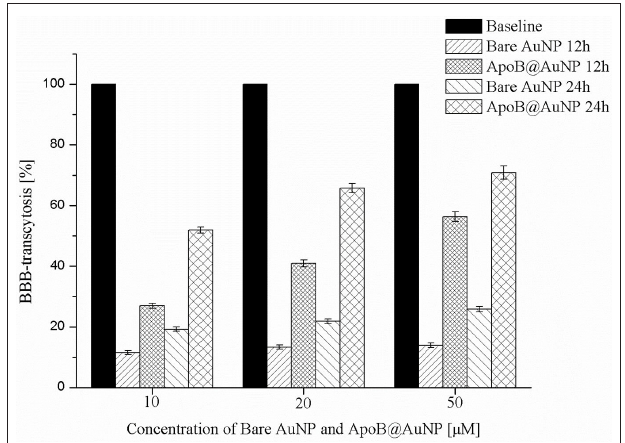
FIGURE 2 | The results of TEER test of ApoB@AuNP. BBB crossing was increased in NP in a dose-dependent manner and enhanced more than two times compared with bare gold nanoparticles, suggesting LDLR-based transcytosis.